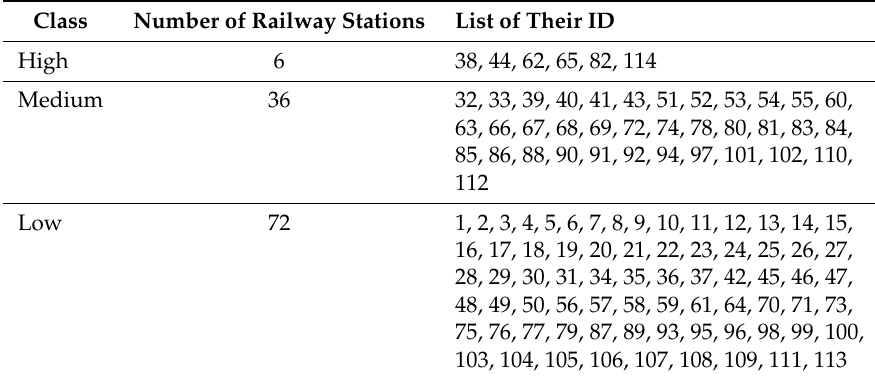
Table 3. The manual classification of the stations.